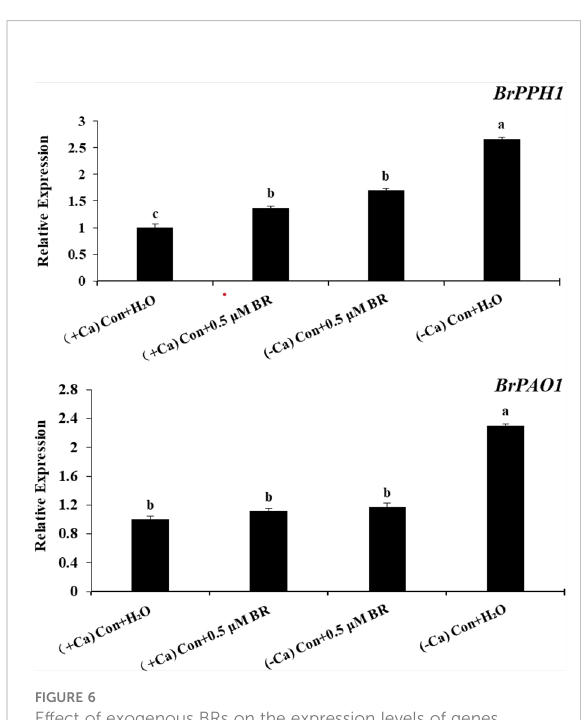
FIGURE 6 Effect of exogenous BRs on the expression levels of genes related to chloroplast degradation in mini Chinese cabbage leaves. The relative expression level of BrPPH1 and BrPAO1 on ninth day were expressed as mean ± SE (n =3). The different letters above the bars showed signi fi cantly different among treatments according to Duncan ’ s multiple test ( P <